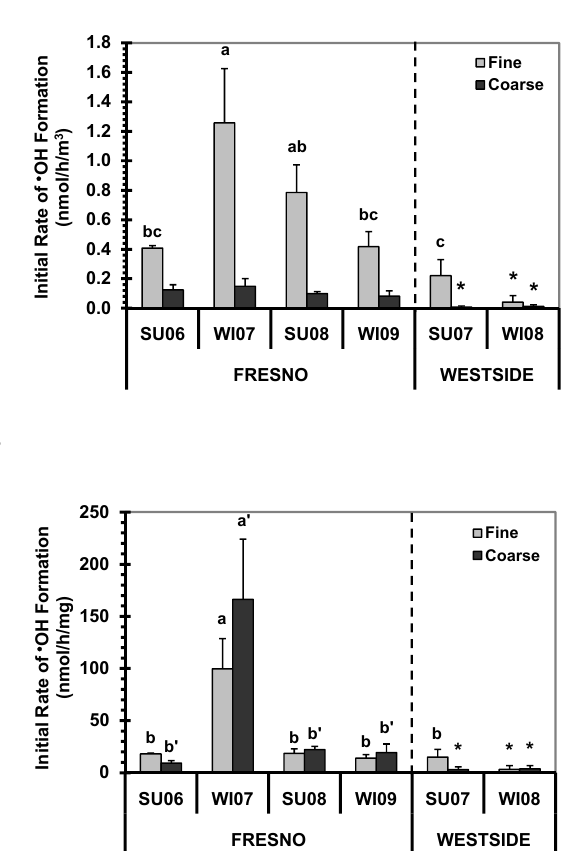
Fig. 3. Rates of • OH generation in the presence of 50µM ascorbate. Panel (a) shows air-volume-normalized initial rates of • OH forma- tion, while (b) shows PM-mass-normalized initial rates. Sample